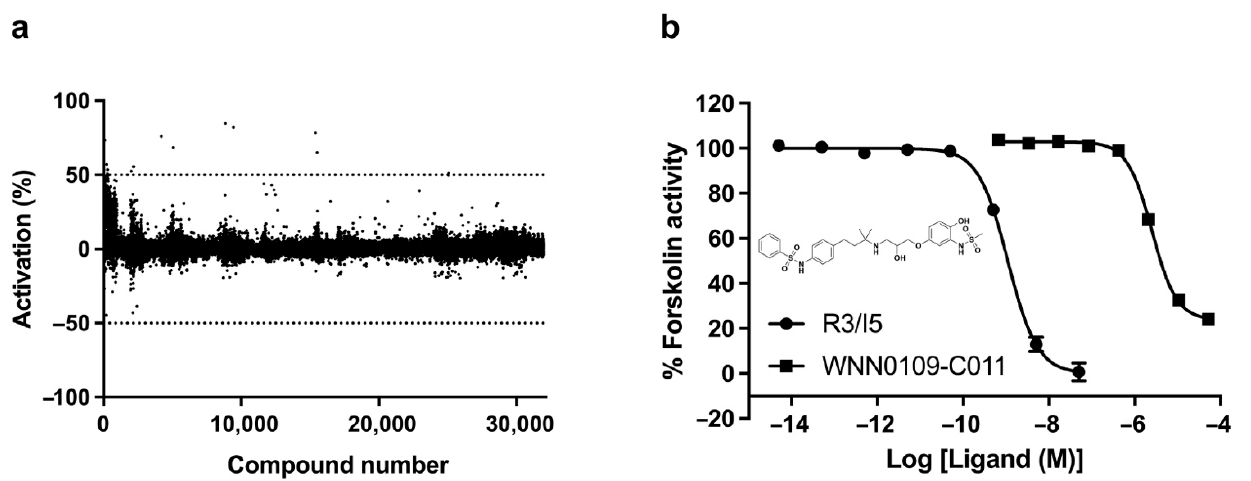
Figure 2. HTS campaign to discover potential RXFP3 agonists. ( a ) Large-scale screening of 32,021 synthetic and natural product-derived compounds. ( b ) Chemical structure of WNN0109-C011 and activation of human RXFP3 by WNN0109- C011.